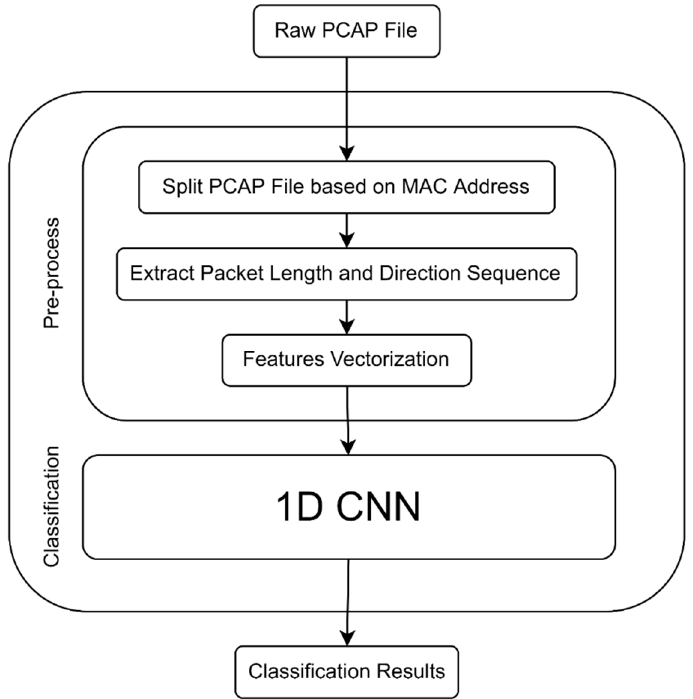
Figure 2. System diagram of the proposed